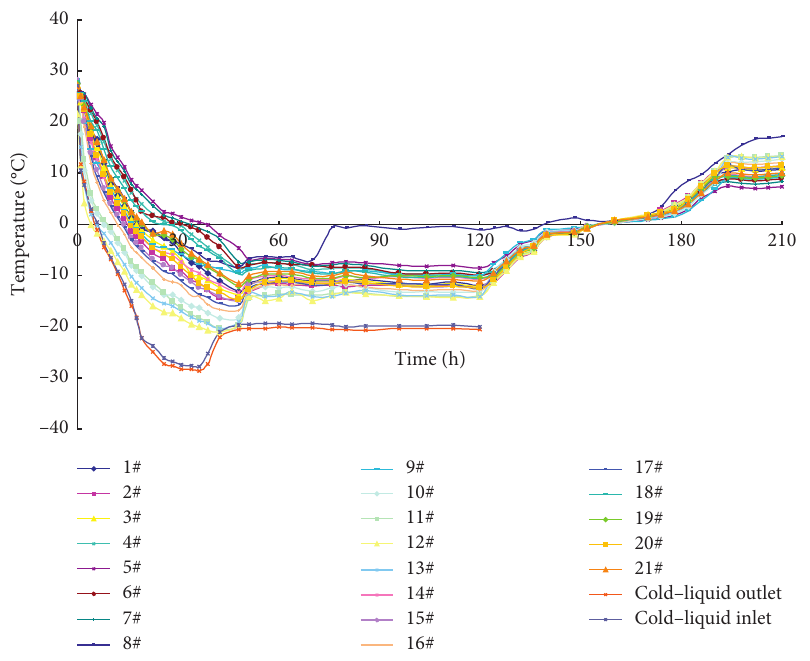
Figure 9: Law of temperature